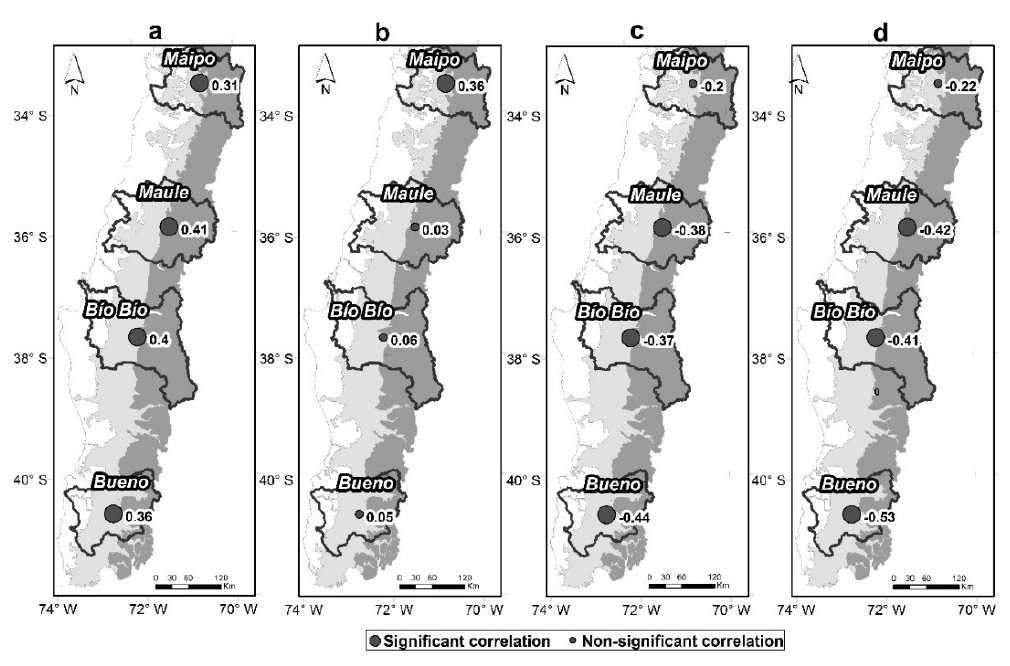
Figure 9. Correlation between hydropower potential and ENSO ( a ), PDO ( b ), SAM ( c ), and AMO ( d ) 373 in the study basins. 374